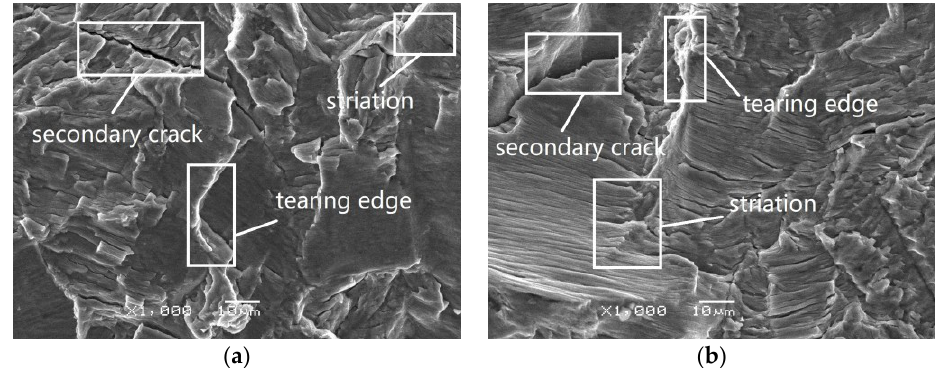
Figure 13. Typical SEM micrographs showing pure fatigue fracture surface morphology at different temperatures under low load ratio:( a ) steady stage, room temperature; ( b )steady stage, T = 300 °C.